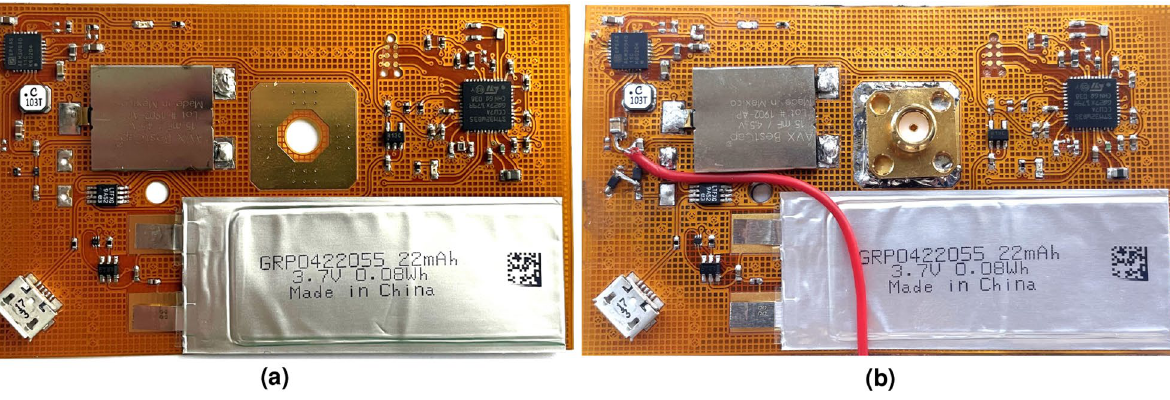
Figure 5. Realized flexible PCB stand-alone (a) and attached to antenna feed plane (b)